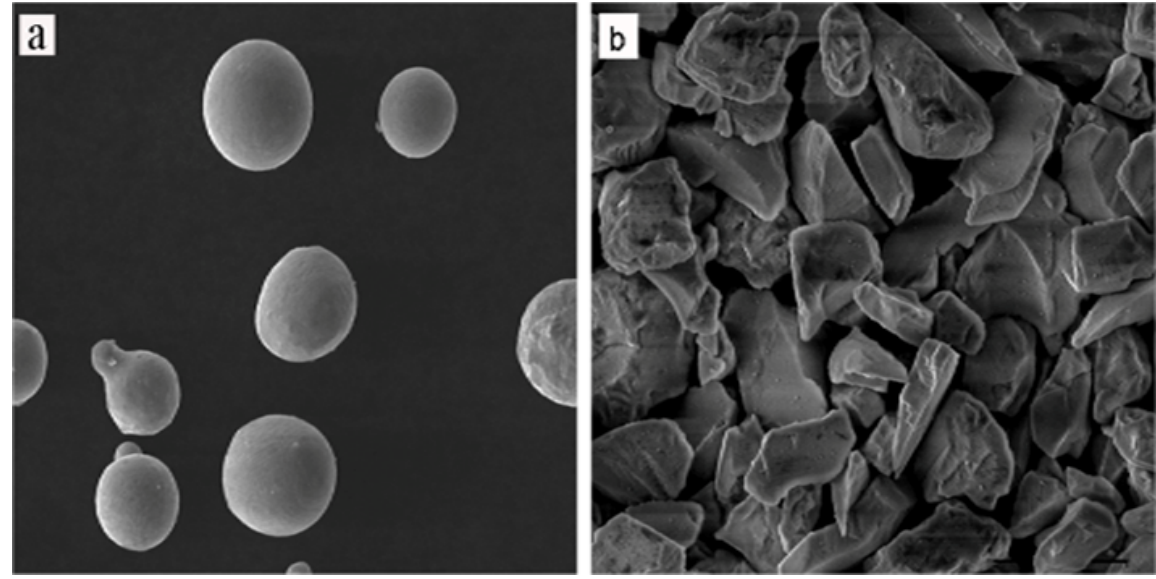
Figure 1: Powder pictures (a)NiCr powder; (b)Al 2 O 3 powder